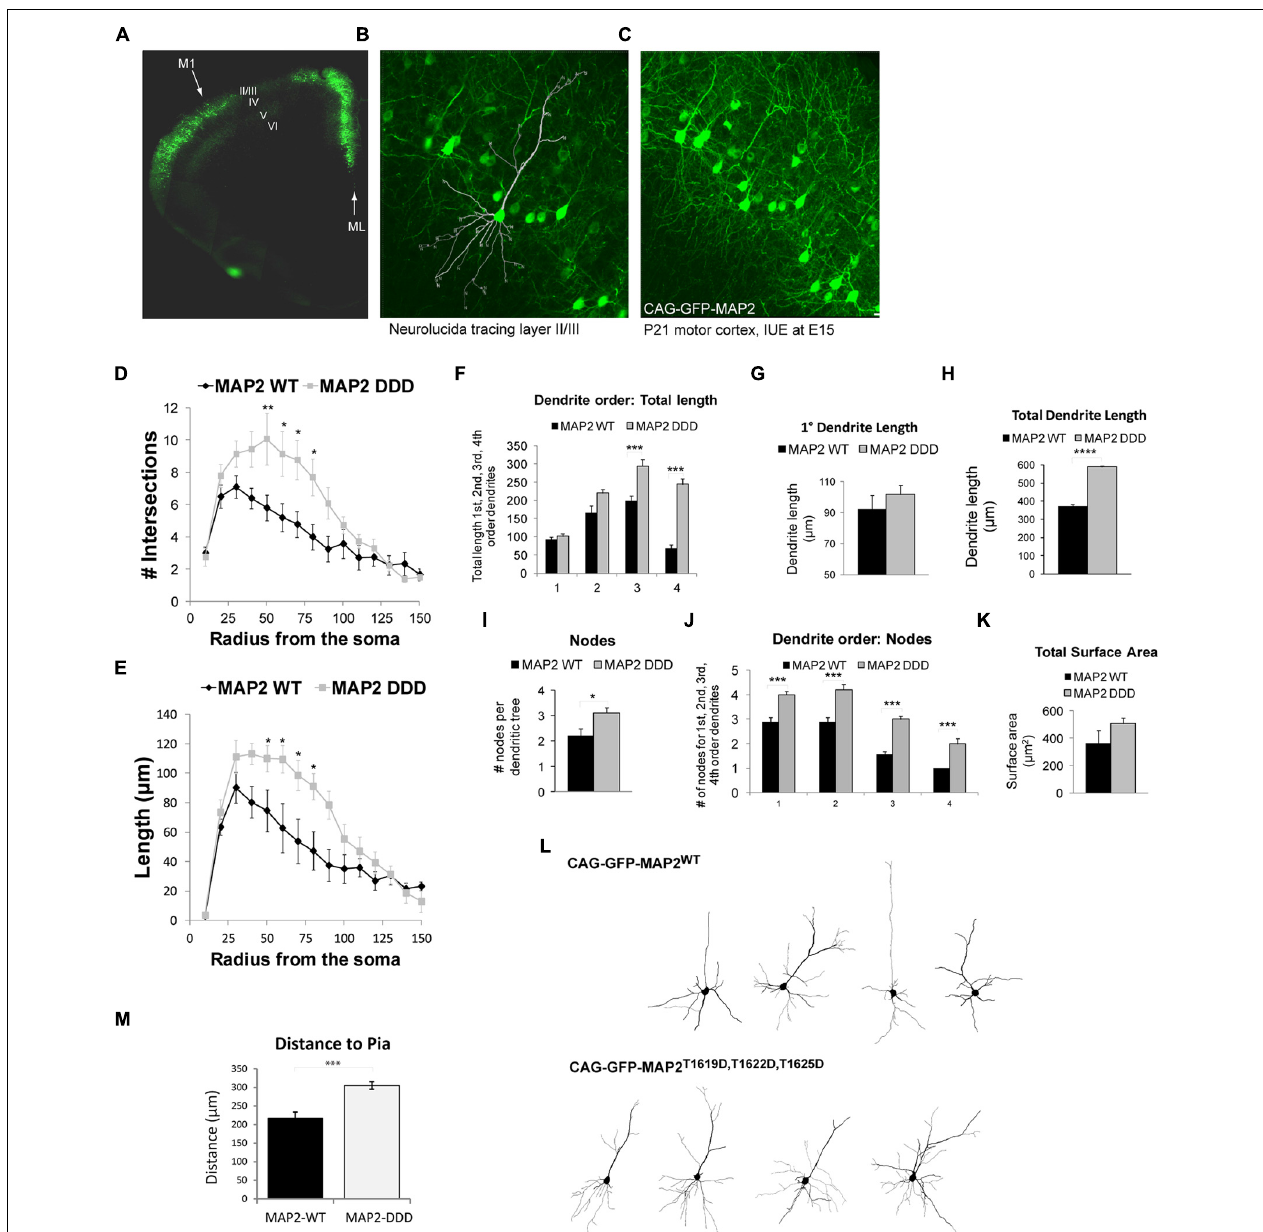
FIGURE 4 | MAP2 T1619D,T1622D,T1625D regulates basal dendrite architecture in vivo . (A) Mice electroporated with DNA at E15 in utero were sacrificed at postnatal day 21. The fluorescent micrograph of a cerebral hemisphere shows expression of GFP in L2/3 of Motor cortex 1 (M1). The midline (ML) is indicated. (B,C) Higher magnification confocal micrographs of L2/3 depicting the neurolucida tracing (B) and the dense network of GFP-expressing cells (C) . (D,E) The number of intersections (D) and dendrite length (E) from Sholl analysis of whole cell basal dendrites from mice electroporated in utero with pEGFP-CAG-MAP2 T1619D,T1622D,T1625D revealed increased dendrite complexity compared to mice expressing pEGFP-CAG-MAP2 WT . (F) There was a significant increase in dendrite length in third and fourth order branches. (G) Primary dendrite length however remained unchanged. (H) There was a significant increase in total dendrite length in MAP2 T1619D,T1622D,T1625D expressing mice. (I) The average number of